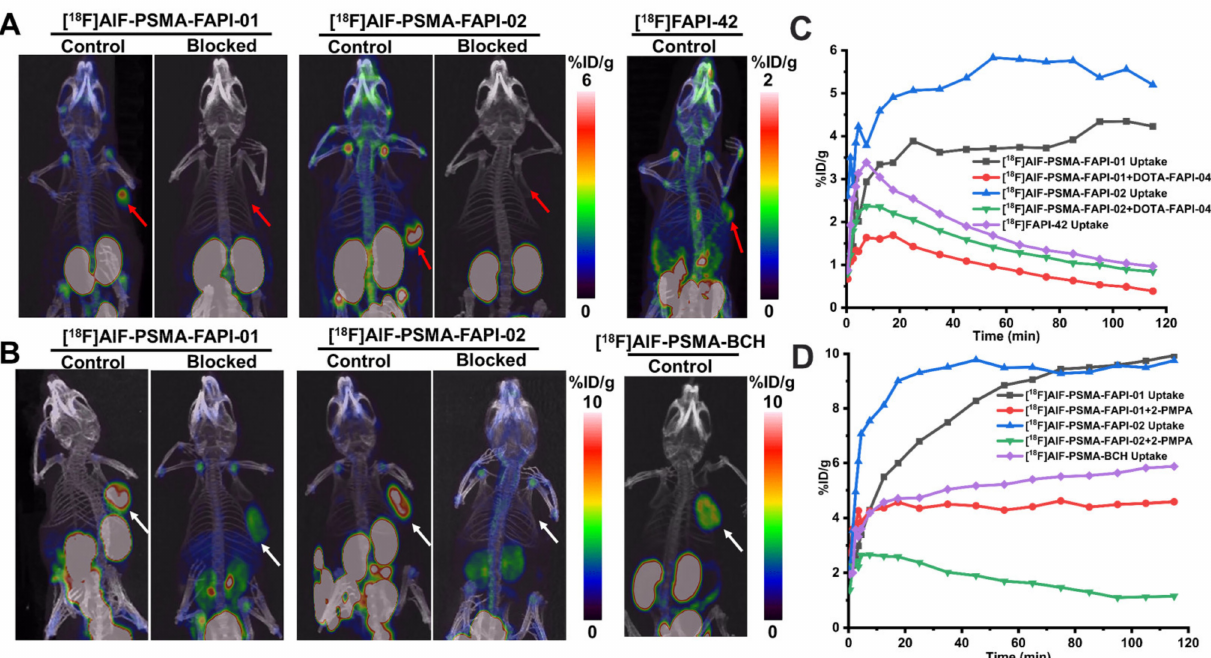
Figure 7. ( A ) Representative MIP images of A549-FAP xenografts at 120 min p.i. of [ 18 F]AlF-PSMA- FAPI-01, [ 18 F]AlF-PSMA-FAPI-02, and [ 18 F]FAPI-42 with and without the FAP competitor DOTA- FAPI-04 (3 mg/kg). The A549-FAP tumors are indicated by red arrows. ( B ) Representative MIP images of 22Rv1 xenografts at 120 min p.i. of radiotracers with and without the PSMA competitor 2-PMPA (3 mg/kg). The 22Rv1 tumors are indicated by white arrows. Time–activity curves